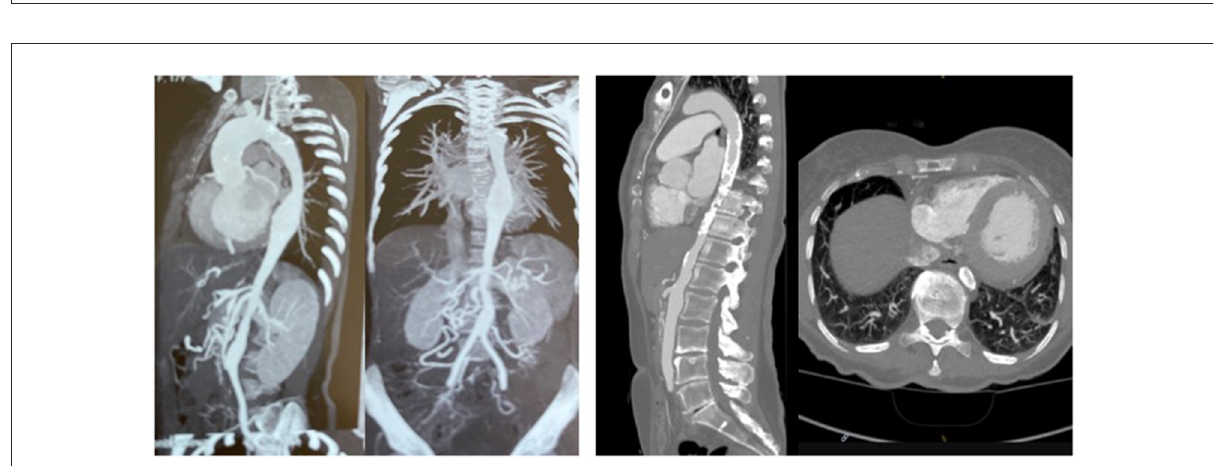
FIGURE13 Left (2 pictures): CT-angiogram of a young patient with Takayasu aortitis with multiple stenoses in the thoracic and abdominal aorta and occlusion of the iliac arteries scheduled for an descending to bi-iliac extra-anatomic bypass. Right (2 pictures): CT-angiogram of a 45 yr-old female with severe calcific narrowing of the descending aorta as a result of a Takayasu more than 25 years before. Endovascular procedure was thought to be not ideal in this